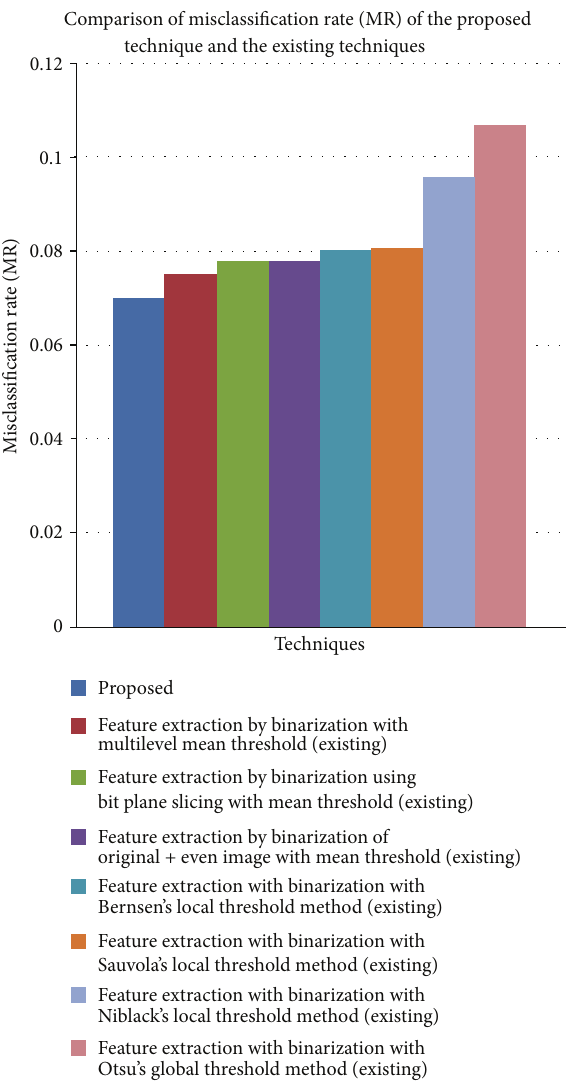
Figure 10: Comparison of misclassification rate (MR) of the proposed technique with respect to the existing techniques.